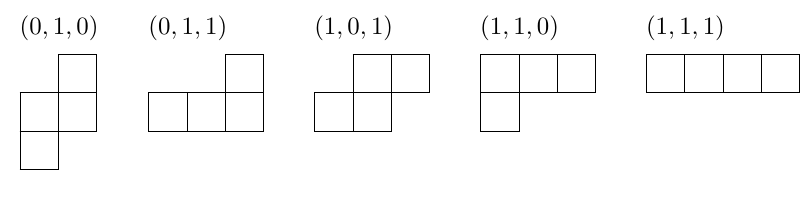
Figure 2 . Allowed su(0 j 2) motifs for N = 4 spins and their corresponding border